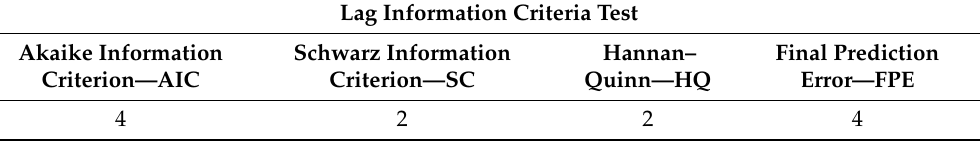
Table 4. Lag information criteria test.